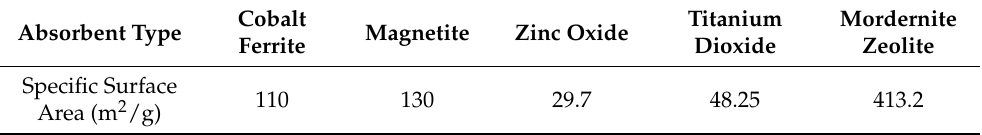
Table 1. Material specific surface area determinate by Brunauer–Emmett–Teller theory